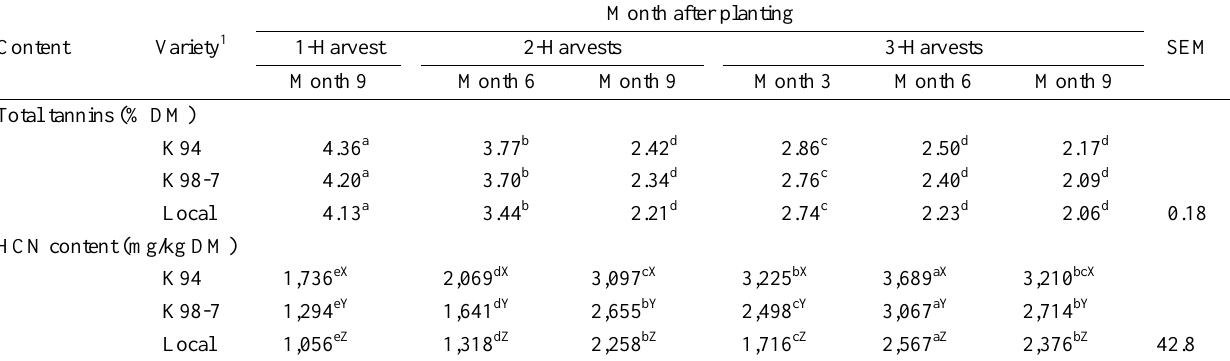
Table 3. Content of total tannins and HCN of three varieties of cassava foliage with a three, two or one harvest system at 3, 6, and 9 months after